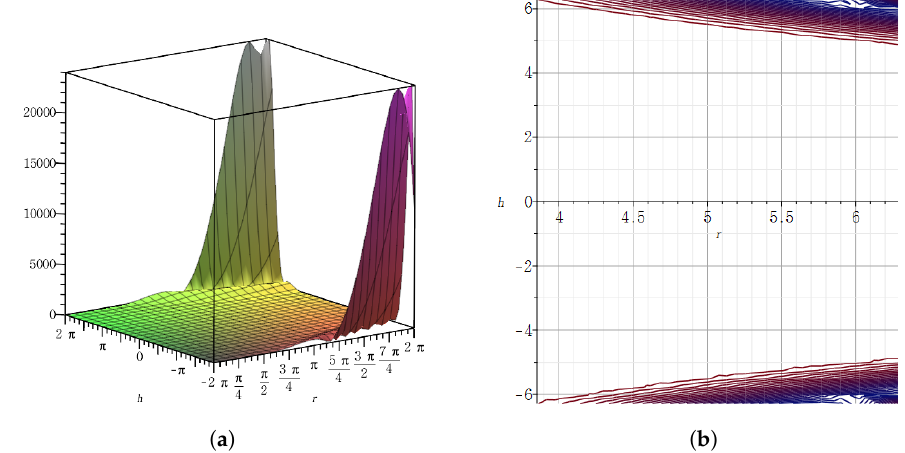
Figure 3. ( a ) Three-dimensional (3D) graph showing the relative error of cos z at z 0 according to h and r . ( b ) Contour line drawn on a plane to estimate the distribution and magnitude of the relative